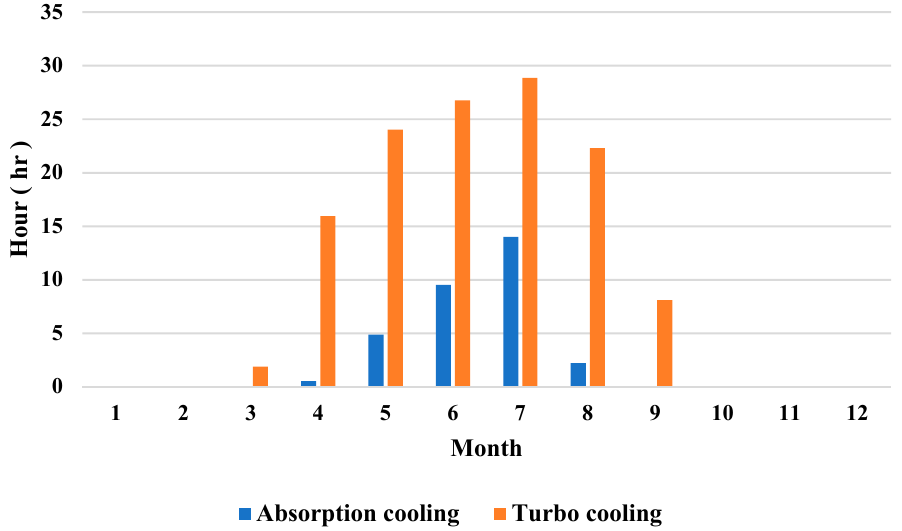
Figure 9. Monthly averaged daily operation hours for turbo and absorption chillers for Case B.